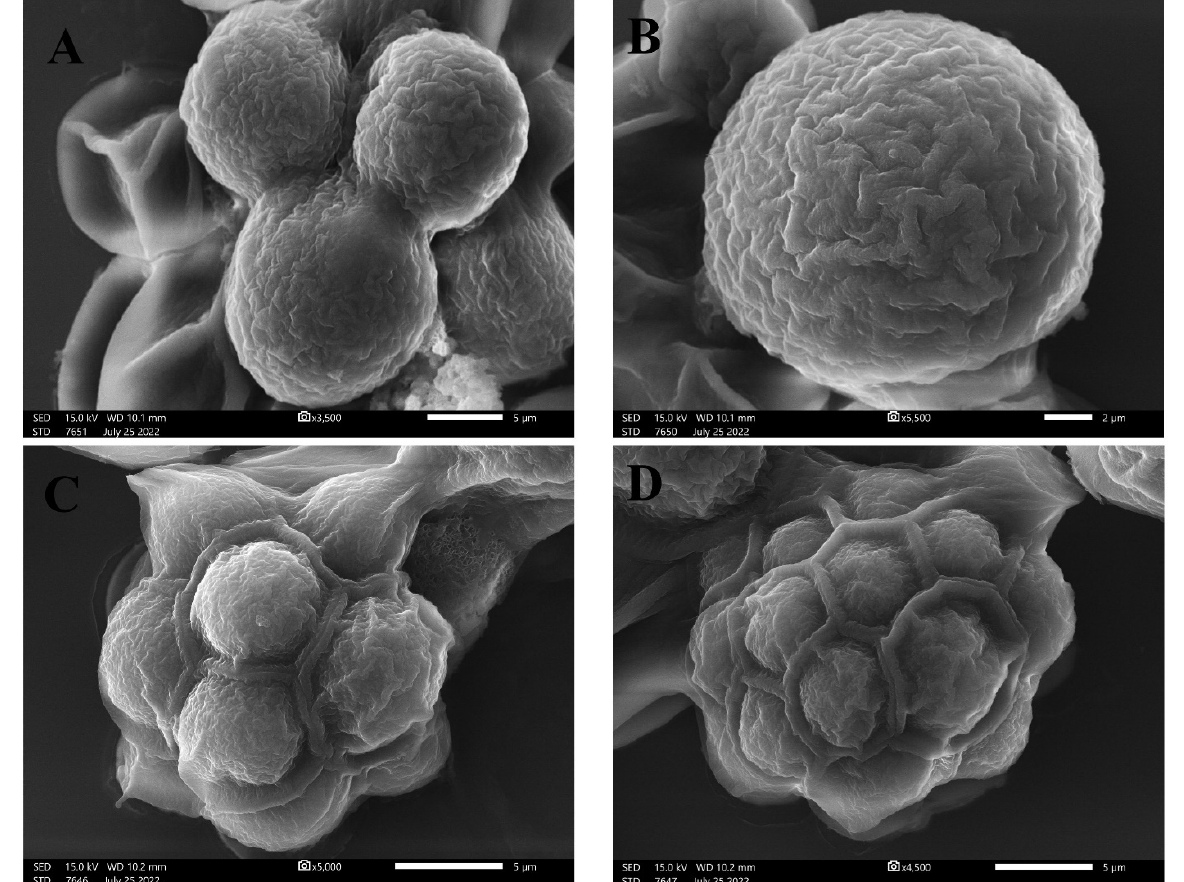
Figure 2. SEM micrographs of unicellular ulvophyte sp. MBIC10591 showing the morphology of single cells of ulvophyte sp. MBIC10591 ( A , B ) and package cells with a parenchyma-like structure containing more daughter cells ( C , D ). Scale bar = 5 μ m ( A , C , D ) and 2 μ m ( B ).